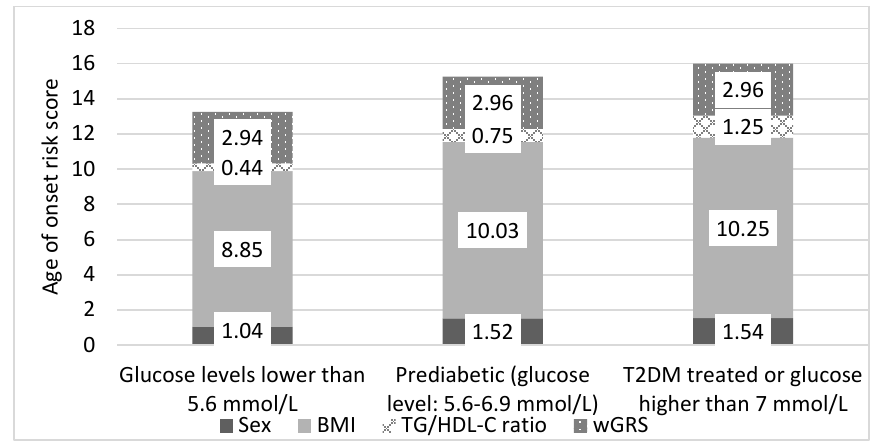
Figure 3. Age of onset risk score values per component (sex, BMI, TG/HDL-C ratio, and wGRS) in the Hungarian general population by subpopulations.